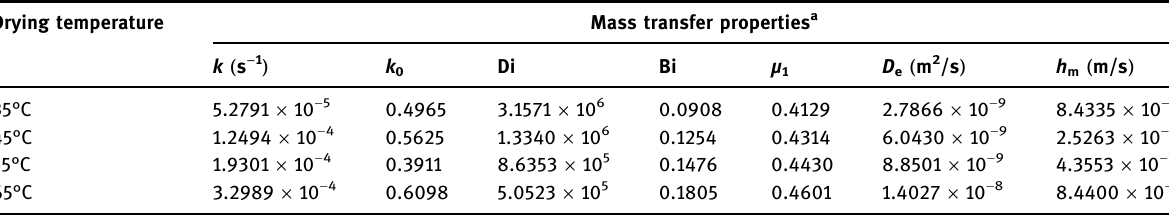
= lag factor; Di = Dincer number; Bi = Biot number; μ 0